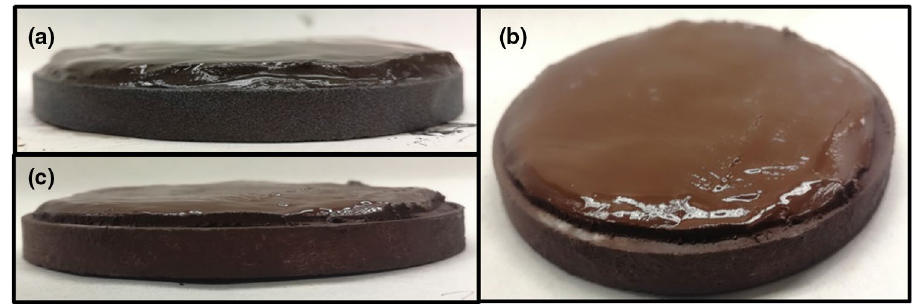
Fig. 10 Formed filter